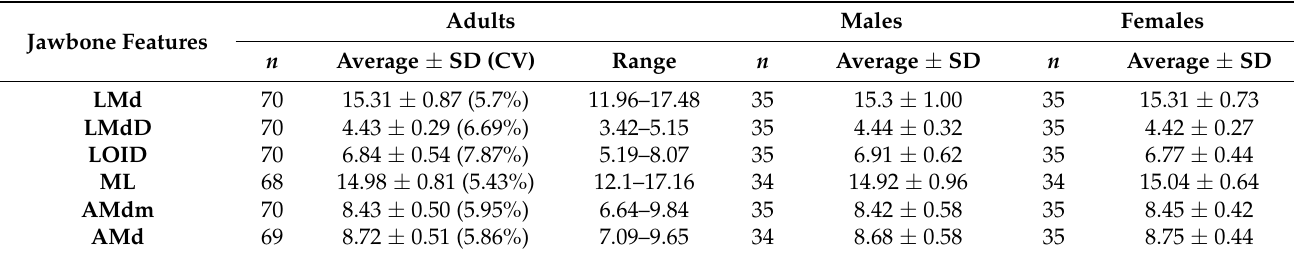
Table 7. Adult jaw-bone characteristics of Pannonian root vole.